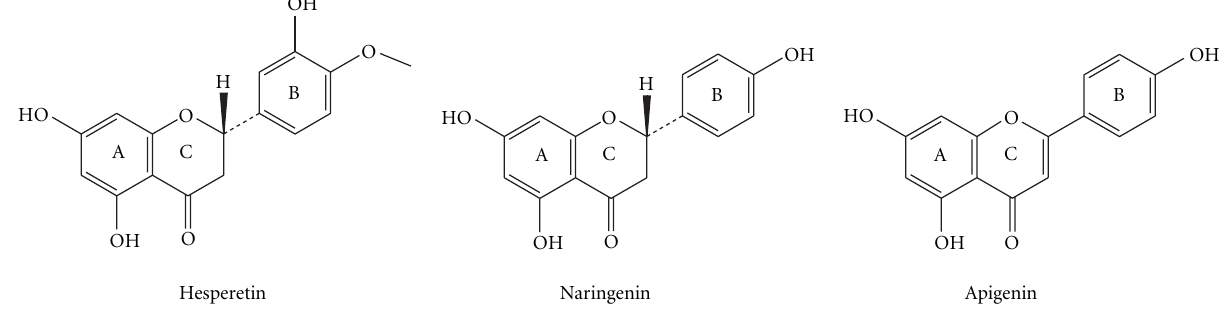
Scheme 1: Structures of the